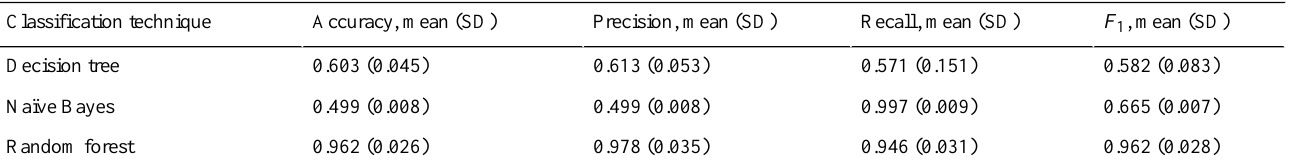
Table 6. Classification of the Repeatable Battery for the Assessment of Neuropsychological Status score performance measures when models trained with 10-fold cross-validation (training set size=740).